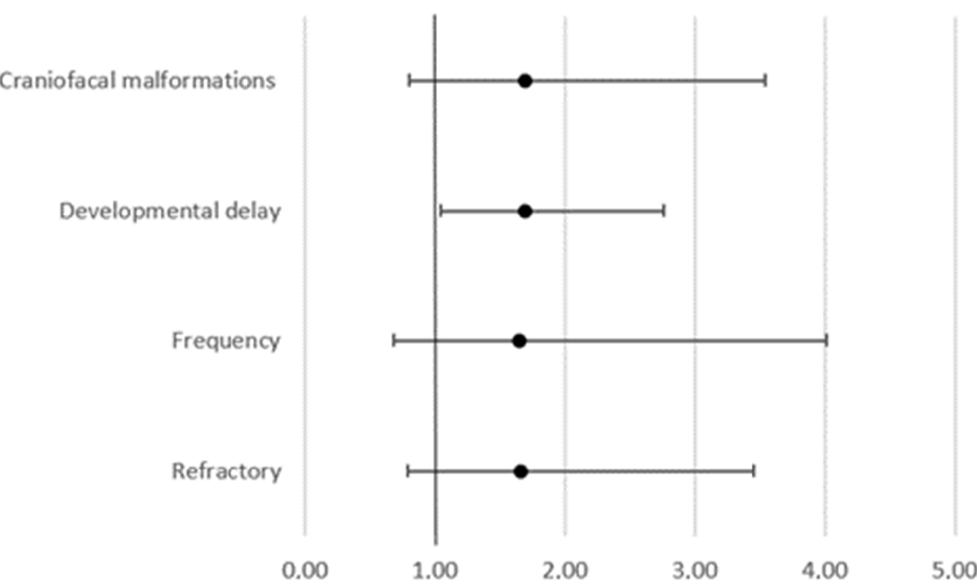
Figure 1. Odds ratio for patient’s characteristics between patients with a negative NGS panel result and patients with variants reported as VUS, LP, or P.